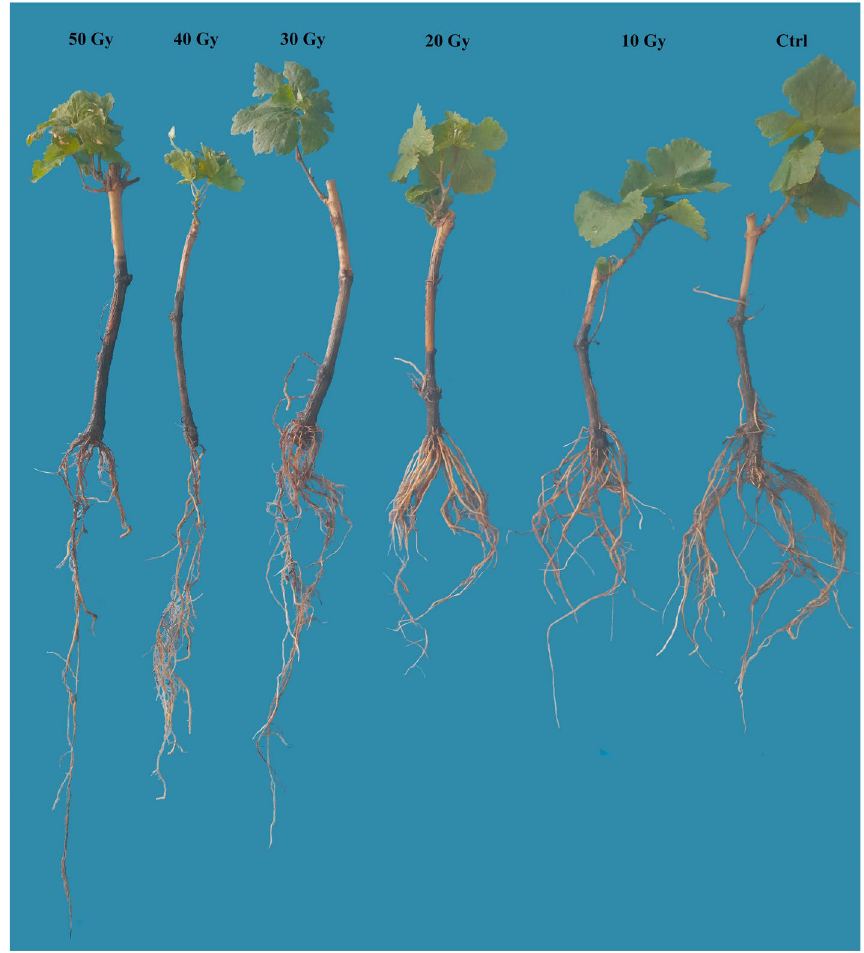
Figure 5. The negative effect of different gamma irradiation doses on morphometric traits of hardwood cutting of ‘Yaghouti’ grape ( Vitis vinifera L.)